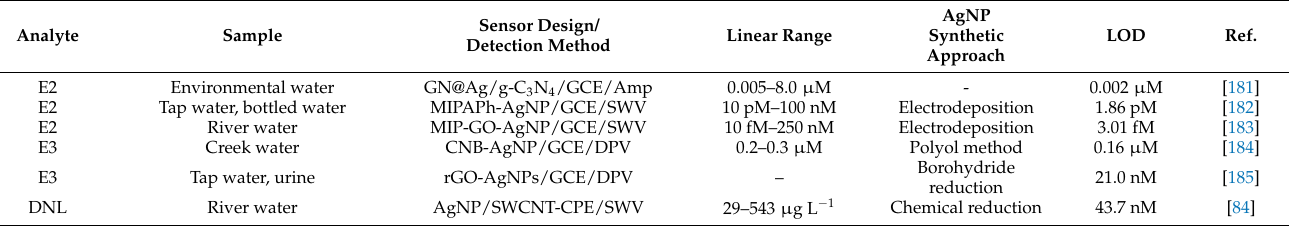
Table 6. Survey of the reviewed silver nanomaterial-based electrochemical sensors for analysis of synthetic and natural estrogens in environmental water